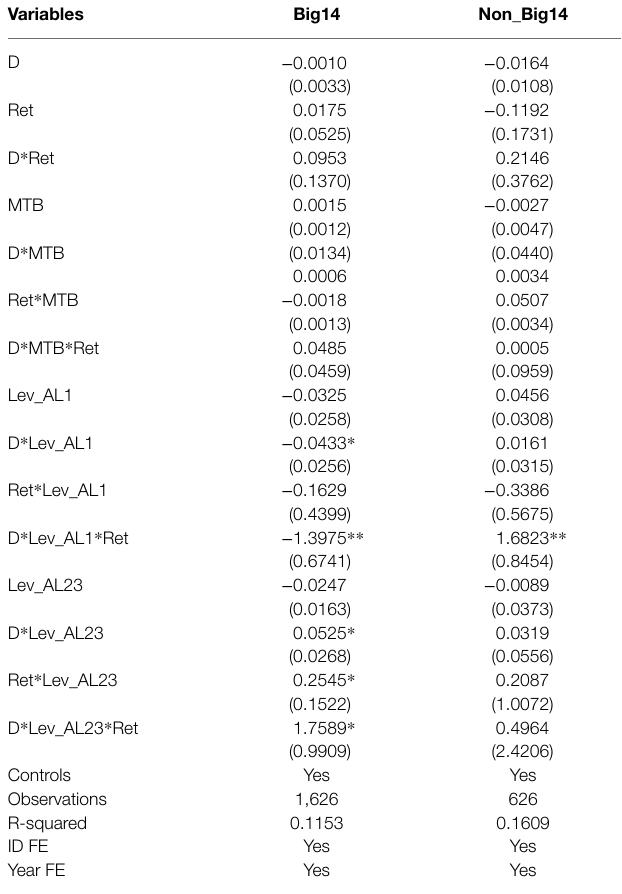
TABLE 6 | Regression results under audit quality